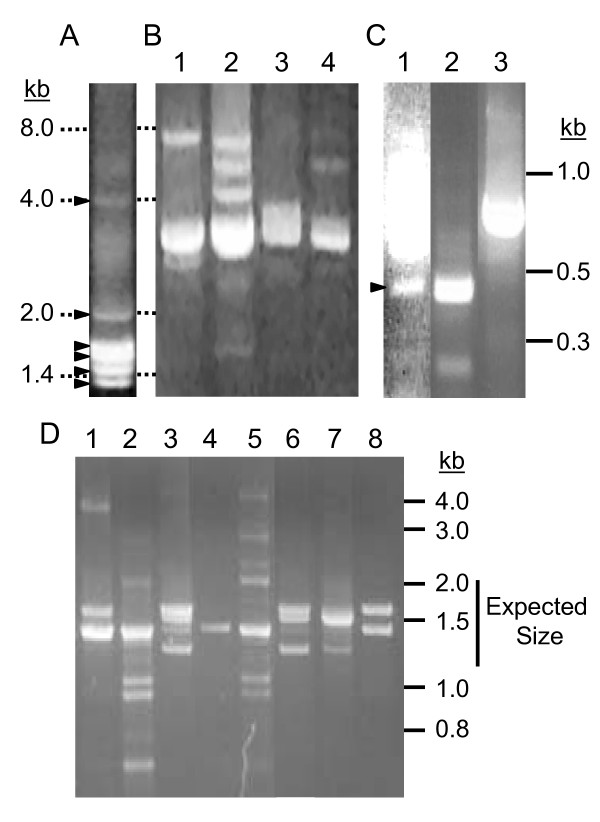
Amplification of 185/333 sequences. A. gDNA from animal 2 was amplified by PCR using primers flanking the 185/333 genes (185-5'UTR and 185-3'UTR; see Table 1) and showed bands of five major sizes from 1.2 to 2 kb and a minor band around 4 kb. Triangles indicate the positions of each of the bands. Similar amplification of gDNA from six additional animals had identical patterns of bands (data not shown). B. Amplification of intergenic regions by PCR using primers that annealed within genes but were oriented away from each other (185-LR1 and 185-F5 primers; Table 1) revealed a major band in all animals of about 3 kb (lanes 1–4, animals 10–13). C. gDNA from animal 2 was amplified by PCR using primers that annealed in the 5' UTR (185-5' UTR; Table 1) and the type I repeats found in elements Ex4, Ex5, and Ex6(185-R5; Table 1) and revealed the presence of genes that lacked introns. Animal 2 gDNA (lane 1) shows a band of 450 bp (indicated with a carrot). A cDNA (Sp0313, DQ183171; lane 2) also amplifies a band of about 450 bp. A cloned gene (2-02, Additional file 1; GenBank accession number EF607673; lane 3) with a typical intron amplifies a band within the range of bands in A. D. PCR amplification of 185/333 from eight different BAC clones using primers (185-5'UTR and 185-3'UTR; Table 1). Each lane contains template DNA from a different BAC (1, 126J14; 2, 108H07; 3, 053M03; 4, 121A07; 5, 004D19; 6, 182N21; 7, 148J22; 8, 019L13).